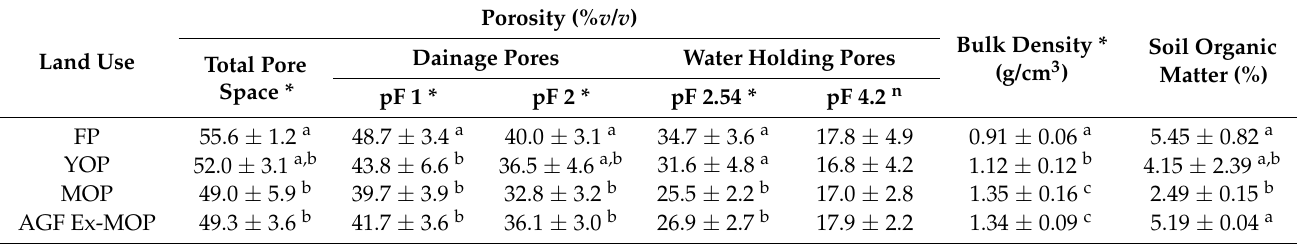
Table 1. The mean values of soil porosity and bulk density.